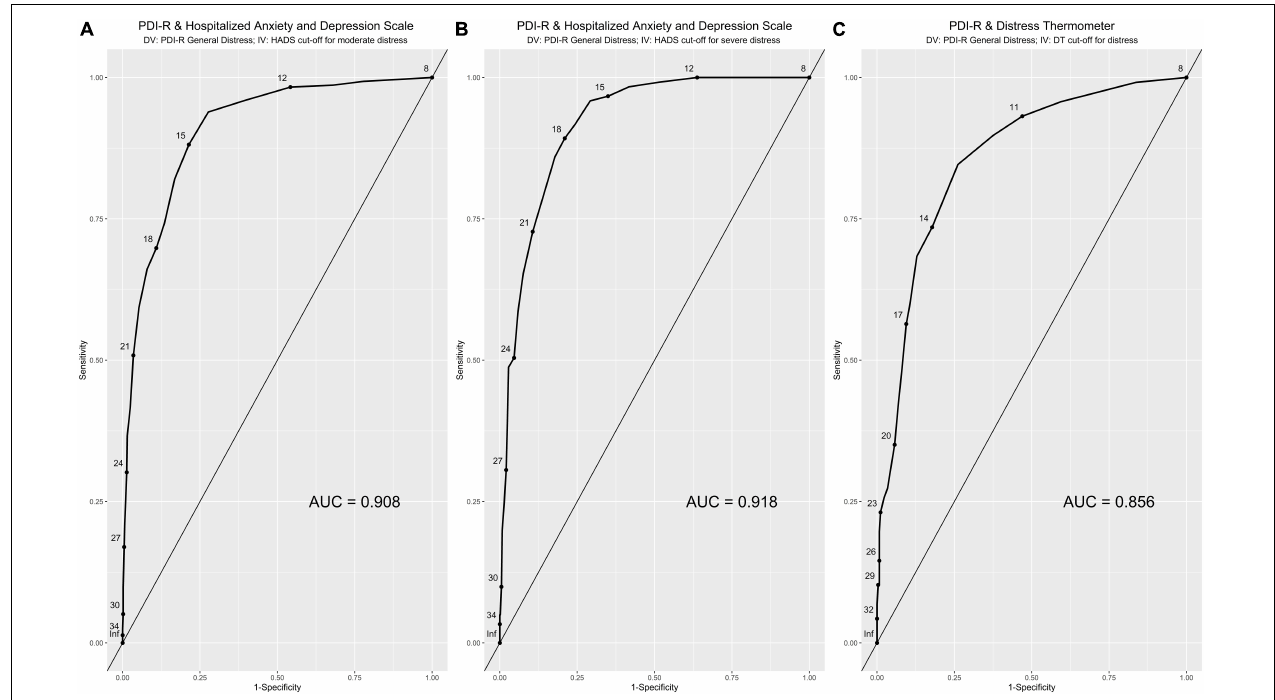
FIGURE 3 | Study 2. ROC curves analysis. HADS cut-offs ( A: moderate distress; B: severe distress) and the DT cut-off (C) . x-axis: 1-specificity; y-axis: sensitivity; AUC = area under the (ROC) curve.